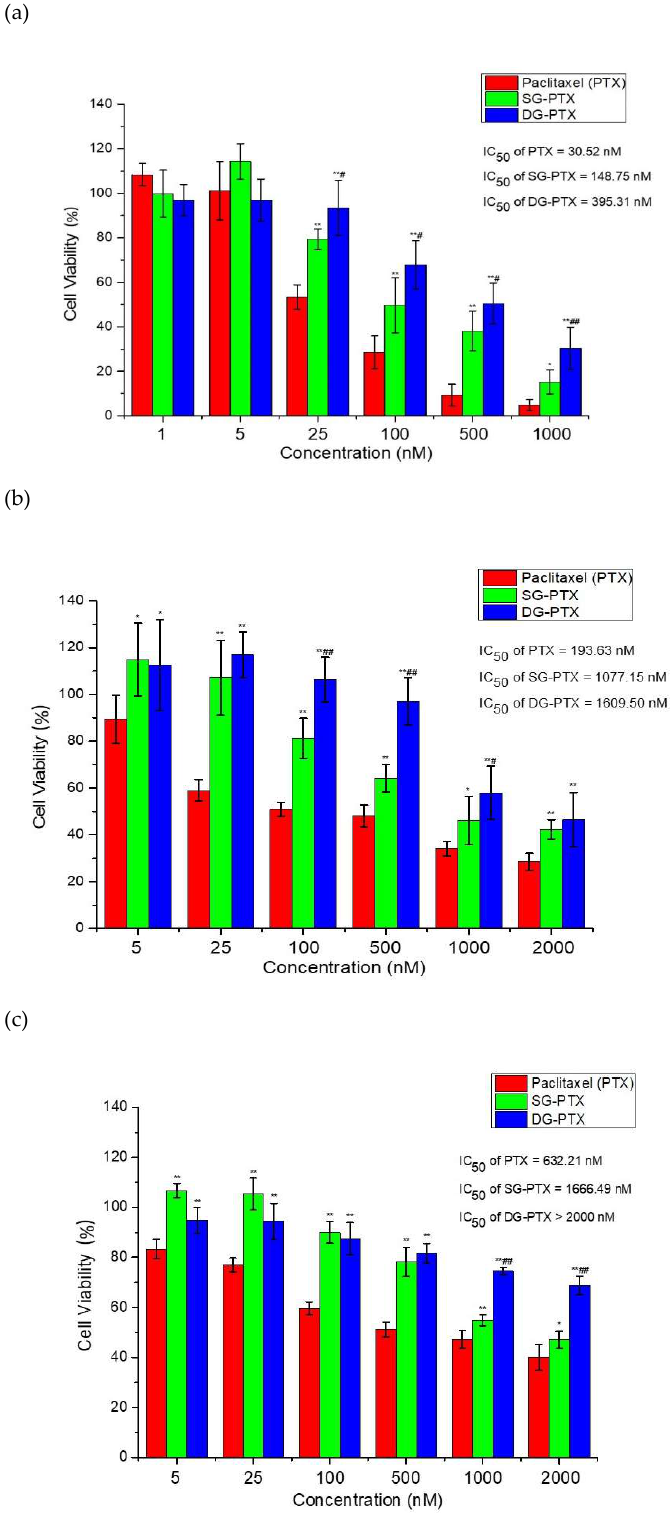
Figure 5. Cytotoxicity of PTX and PTX prodrugs against cancer cells and normal cells. ( a ) breast cancer cells MDA-MB-231, ( b ) ovarian cancer cells A2780, ( c ) normal breast cells Hs578Bst. All values are expressed as mean ± SD (n = 6). Compared to PTX group, * p < 0.05, ** p < 0.01; compared to SG-PTX group, # p < 0.05 ## p <